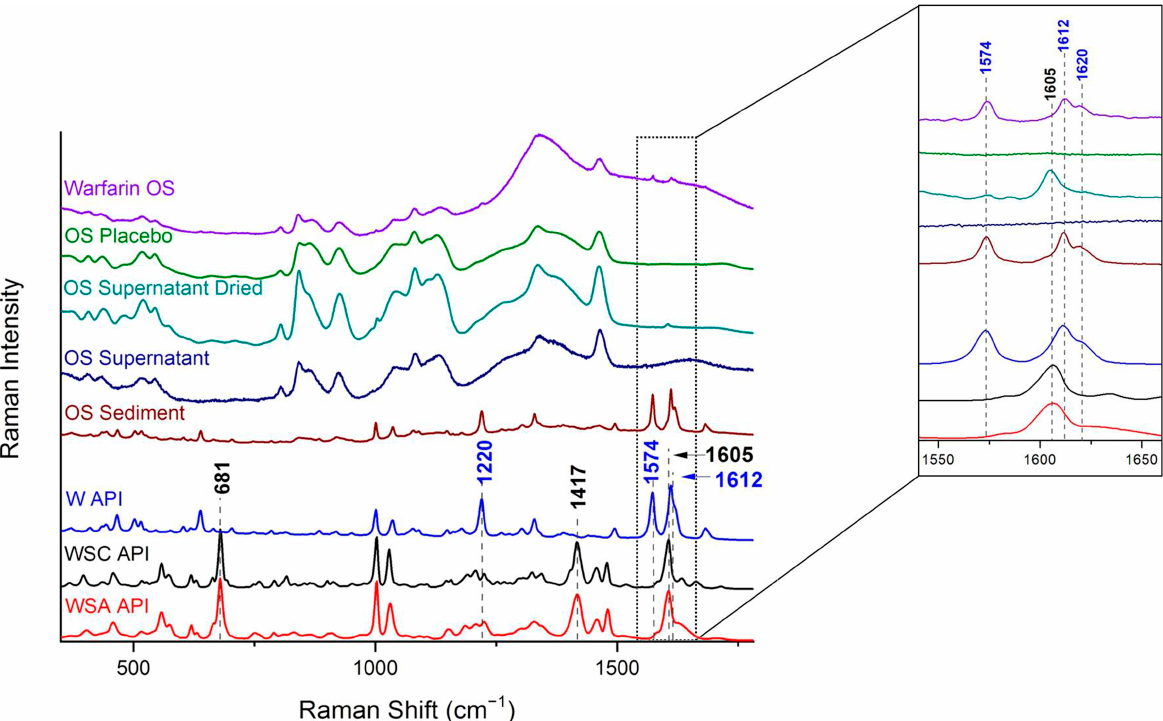
Figure 2. Raman spectra of the warfarin oral suspension (OS), oral suspension placebo, oral suspension supernatant dried, oral suspension supernatant, oral suspension sediment, warfarin (W) API, warfarin sodium clathrate (WSC) API, and warfarin sodium amorphous (WSA) API. Characteristic peaks of the APIs are indicated. Insert: Magnification of spectral area 1550–1650 cm − 1 .